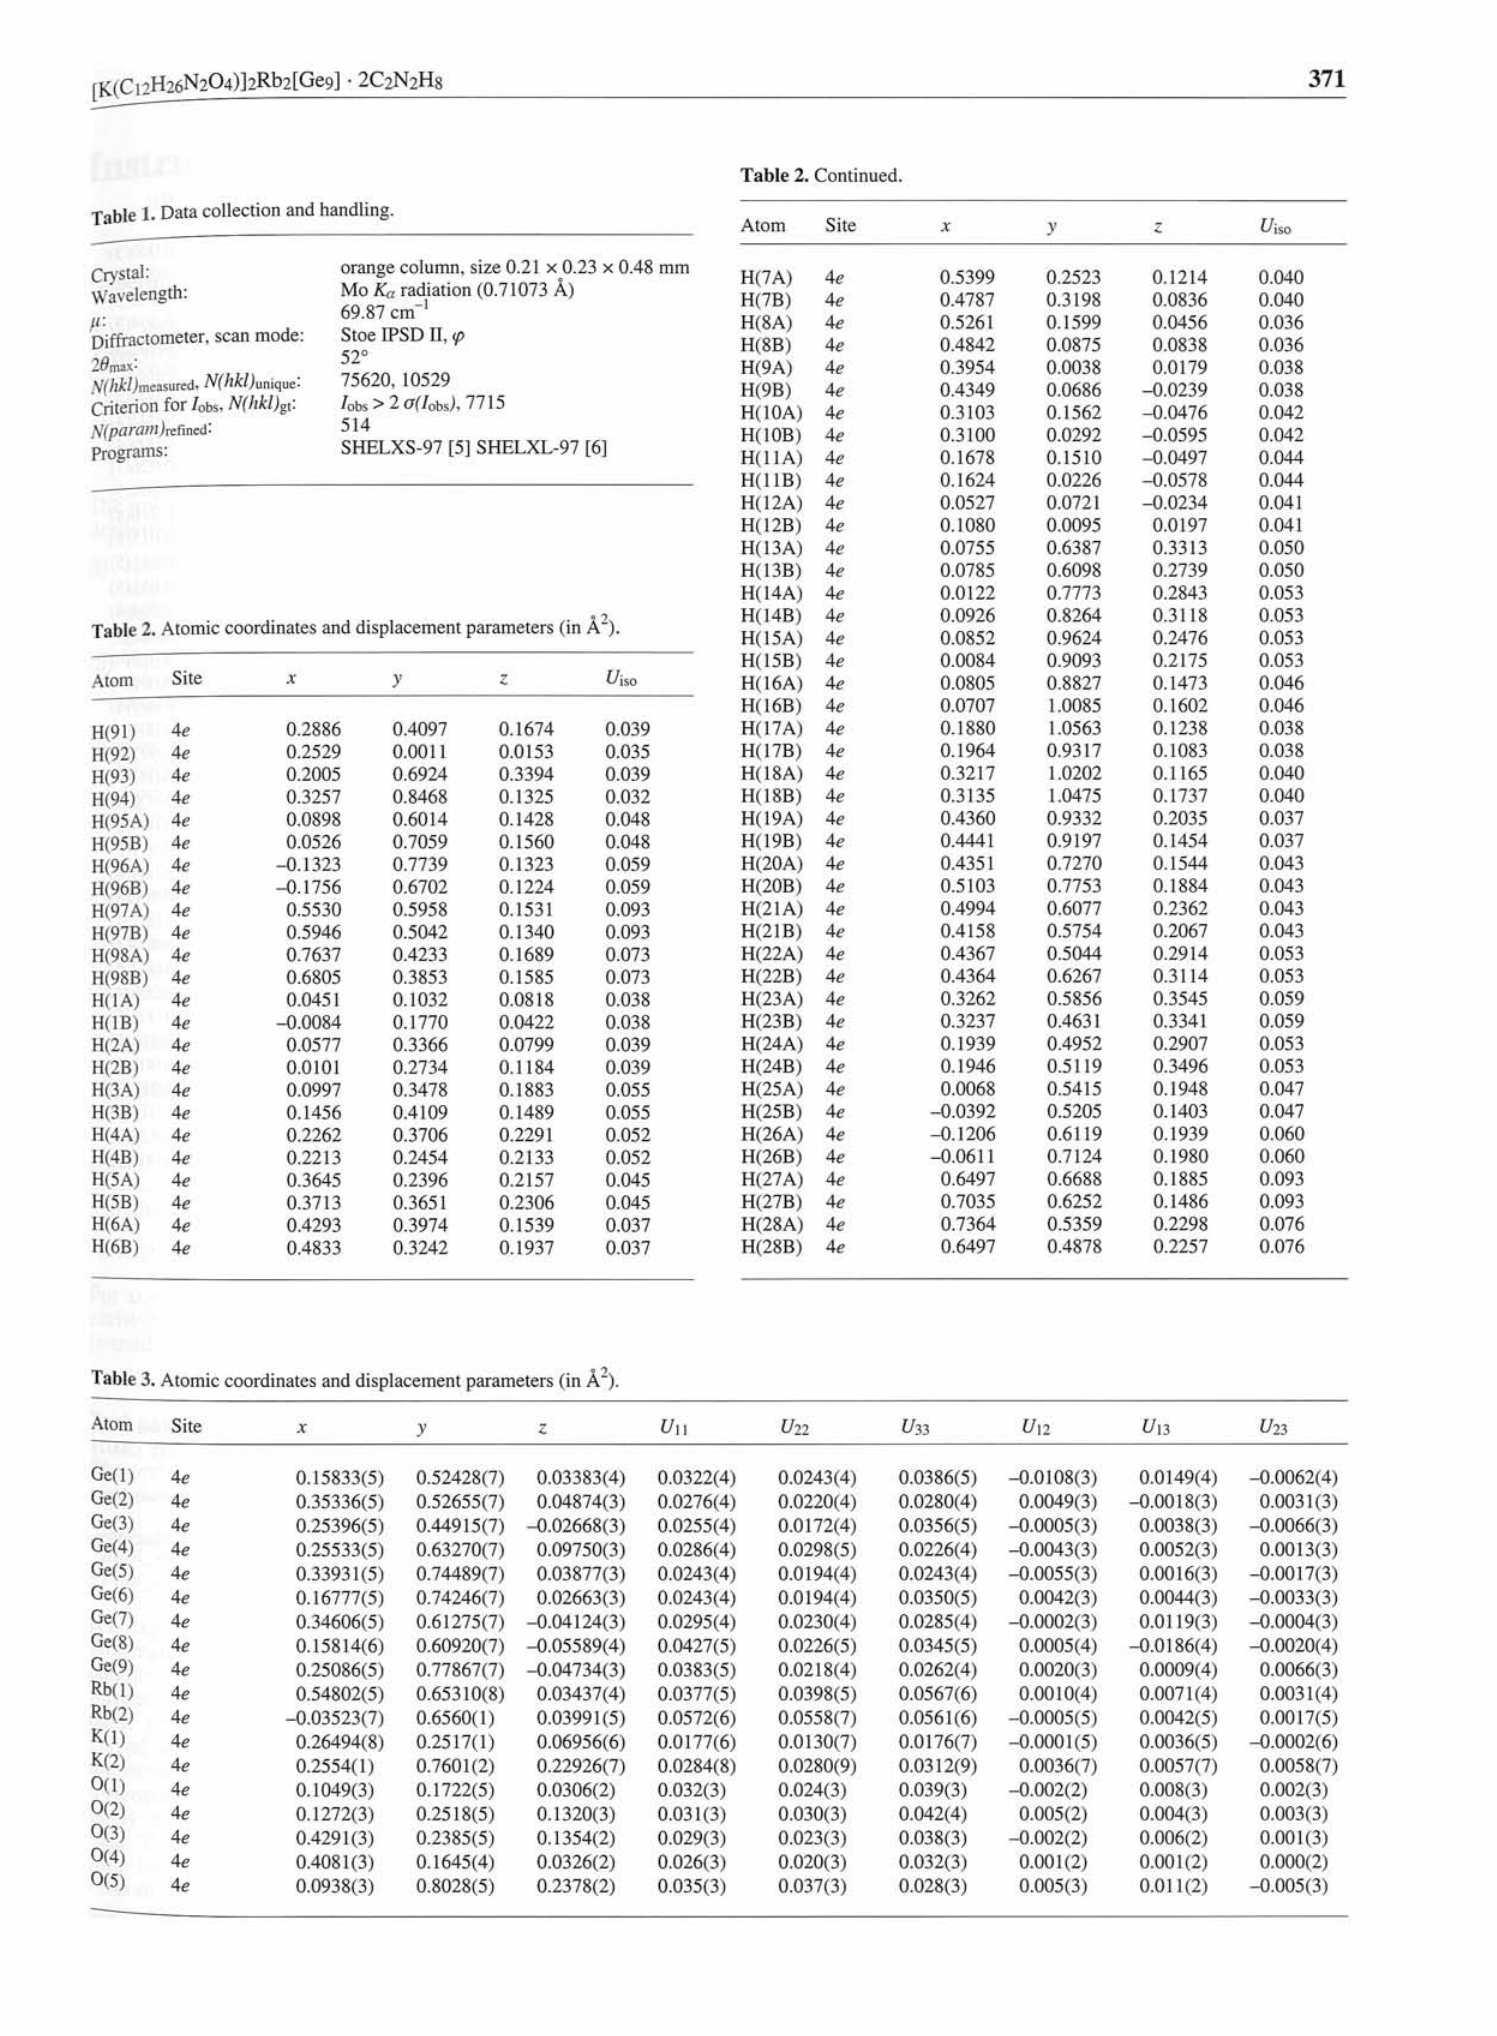
Table 1. Data collection and handling.